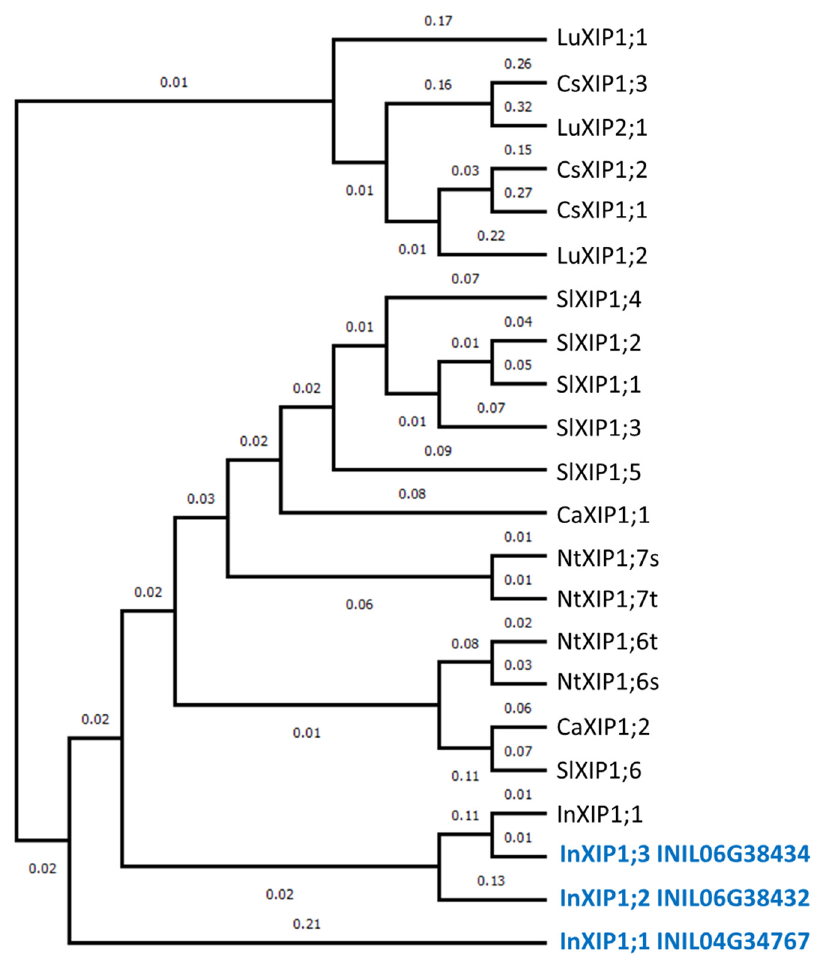
Figure 4. Phylogenetic tree of XIP family members. A phylogenetic tree was generated by the neighbor-joining method derived from a CLUSTALW alignment of the AQP amino acid sequences of Japanese morning glory InXIPs from this study (indicated in blue) and InXIP1;1 (HM475296) [15], alongside tobacco NtXIPs [26], tomato SlXIPs [13], pepper CaXIPs [27], citrus CsXIPs [25], and flax LuXIPs [24]. Numbers on the phylogenetic tree indicate branch length.